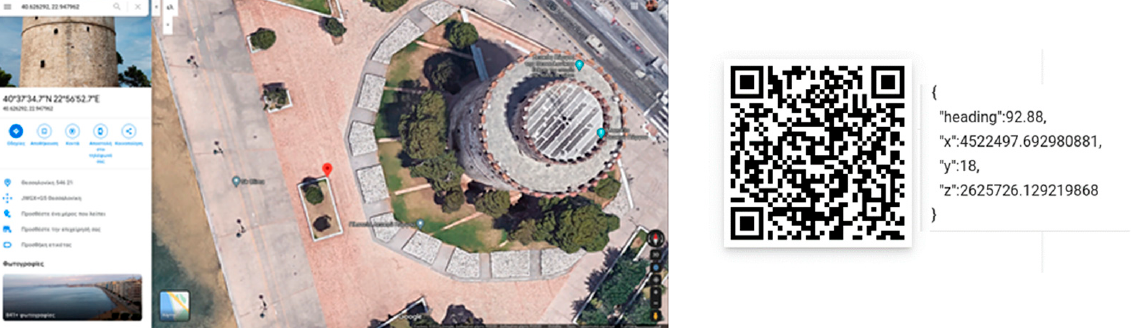
Figure 8. Initializing position and azimuth with a visual tag with QR code. 1.